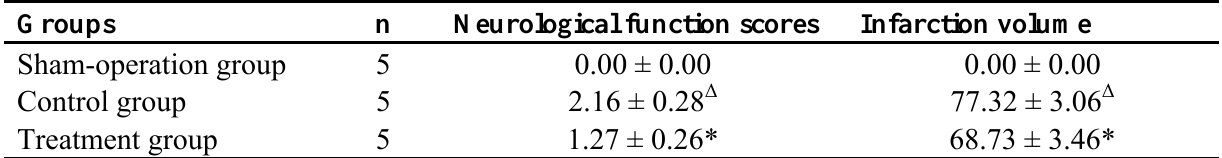
Table 1. Neurobehavioral deficit score and infarct volume ( x ±